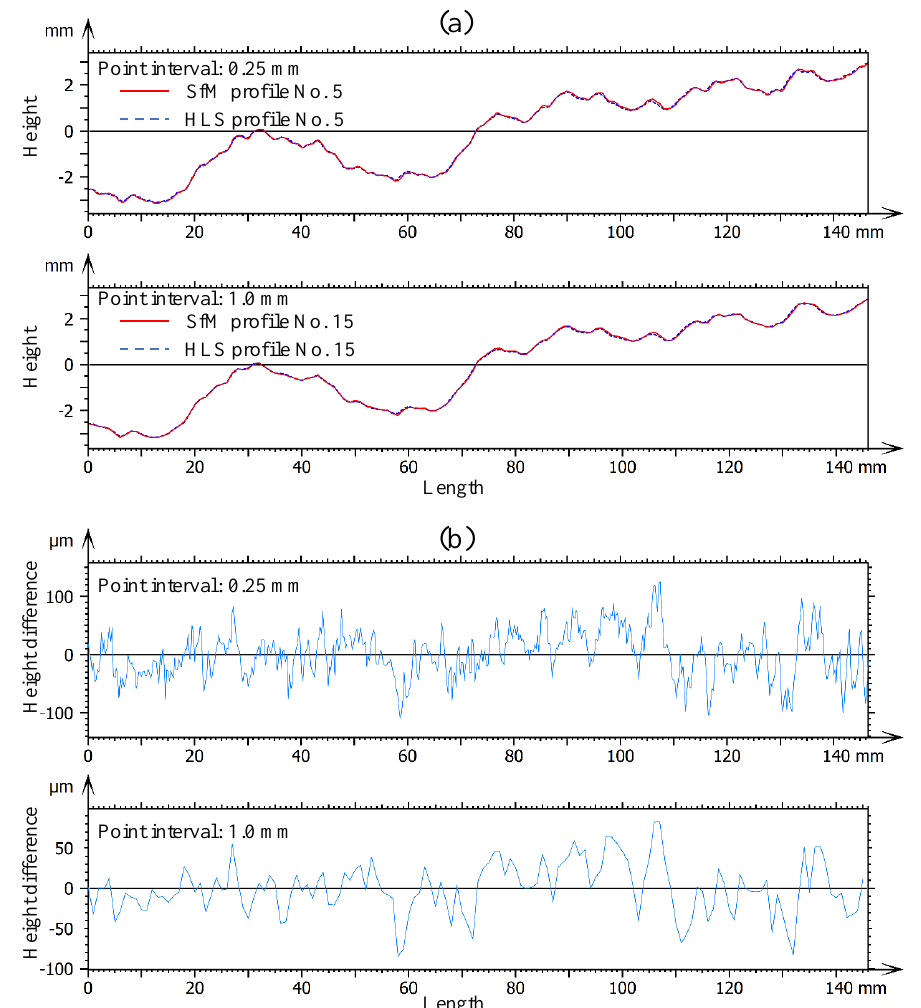
Figure 13. Comparison of the SfM and HLS profiles with different point intervals of 0.25 and 1.0 mm ( a ) from the height of profiles and ( b ) from the height difference of profiles.